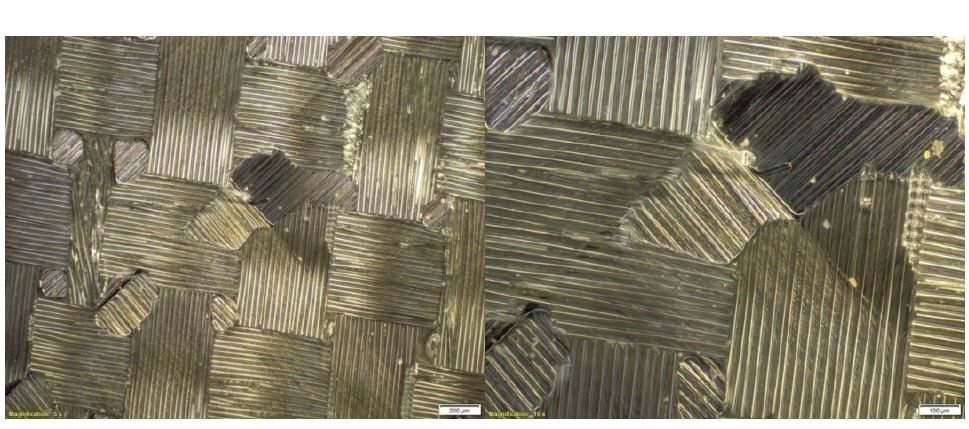
Figure 2 Figure 2. Microstructure of a composite laminate, reinforced with Dialead K63712 modular fabric, reprinted from